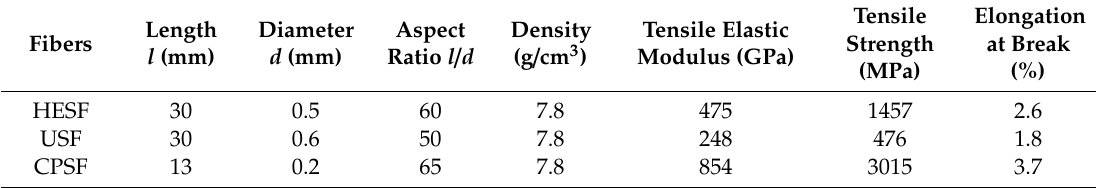
Table 5. Physical properties of steel fibers.